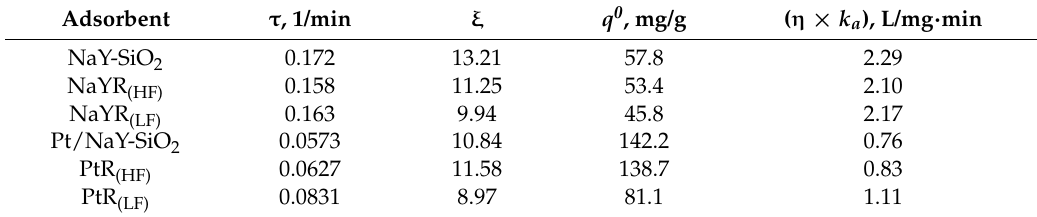
Table 1. Ethanol adsorption capacities and effectiveness factor obtained from breakthrough curves.